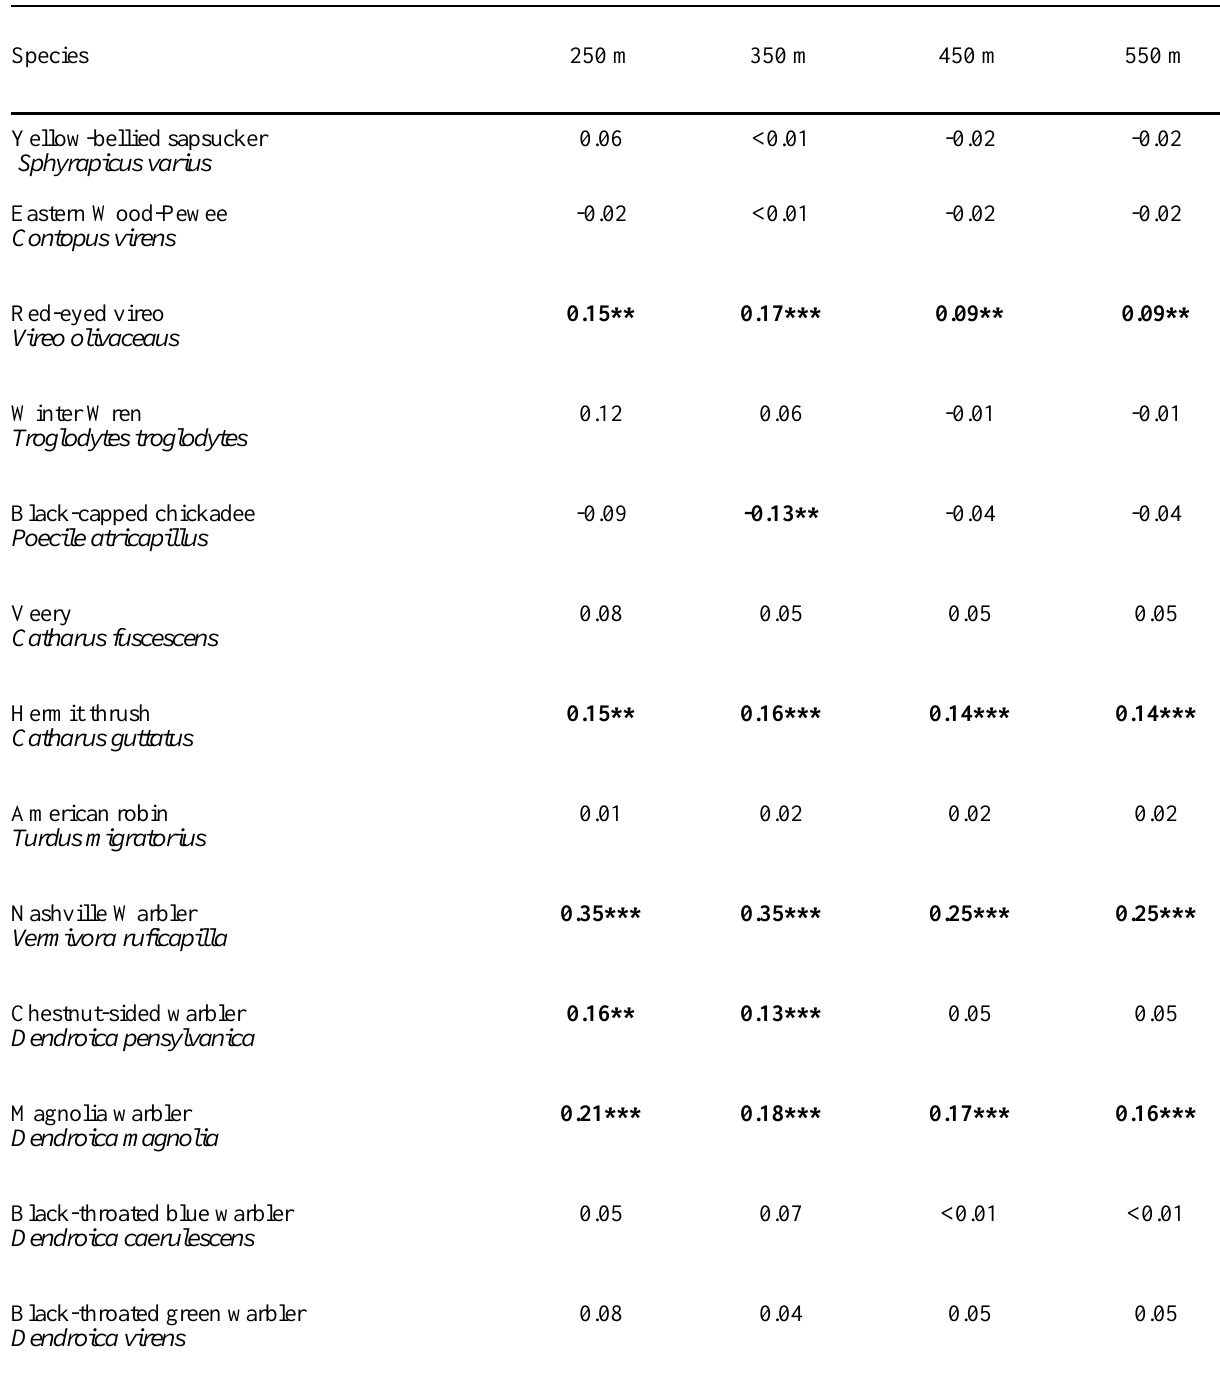
Table 3. Moran’s I correlograms of residuals from general linear models. Negative Moran’s I values indicate regular arrays, whereas positive values indicate clusters. Results of test: ** P <0.01, *** P <0.001.